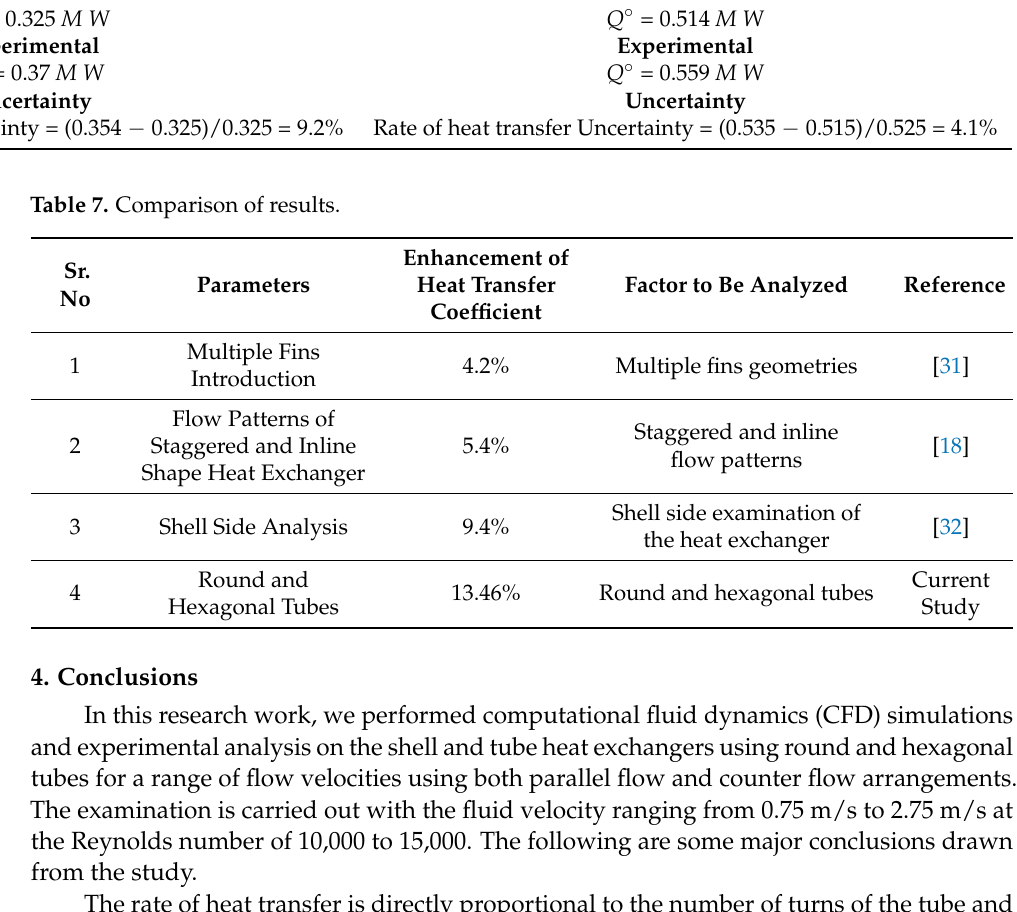
Table 6. Uncertainty calculation on both the tubes of a heat exchanger at optimum fluid velocity. Round Tubes